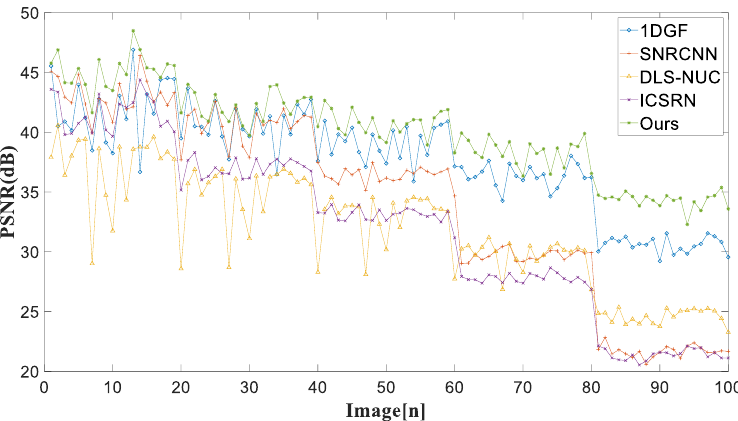
Figure 9. PSNR (dB) of different methods for 100 simulated noise infrared images.